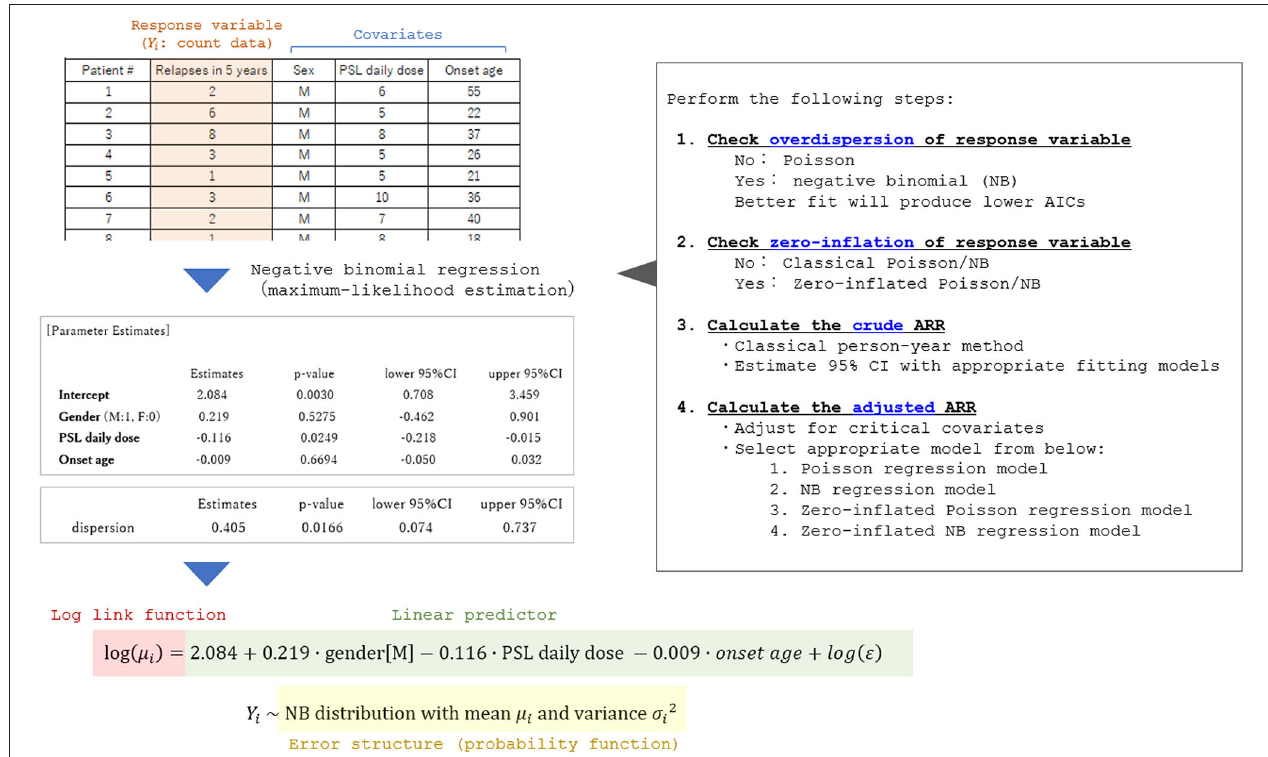
FIGURE 6 | Process of applying the generalized linear model to calculate adjusted ARR. A fictitious dataset from 35 patients with a relapsing disease is used in the analysis. To select an appropriate general linear regression model, overdispersion and zero-inflation of the response variable (relapse count in the dataset) should be checked in advance. By performing the generalized linear regression analyses with appropriate error structures, the coefficient for each critical covariate in the linear predictor function can be obtained together with the 95% CI. By utilizing the obtained prediction expression, the expectation of the response variable adjusted for the covariates (typically set as the means of the whole population) can be